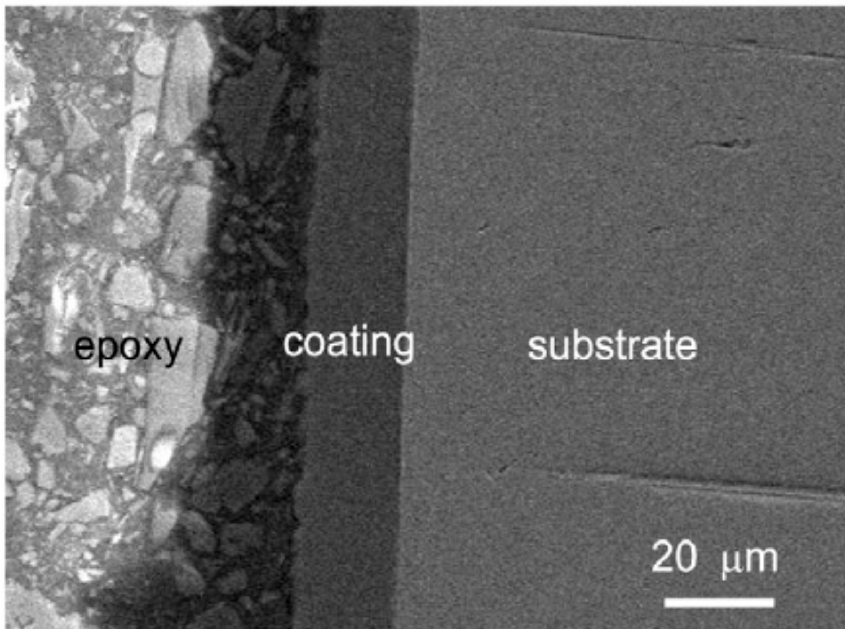
Figure 9. Cross-sectional morphology of Al coating on U: anodically etched in AlCl 3 -[EMIm]Cl (2:1) ionic liquid at 20 mA ∙ cm − 2 for 10 min, then electrodeposited in AlCl 3 -[EMIm]Cl (2:1) ionic liquid at 20 mA ∙ cm − 2 for 72 C ∙ cm − 2 [Reproduction with permission from Jiang, Y.; Ding, J.; Luo, L.; Shi, P.; Wang, X., Surf. Coat. Tech.; published by Elsevier, 2017].